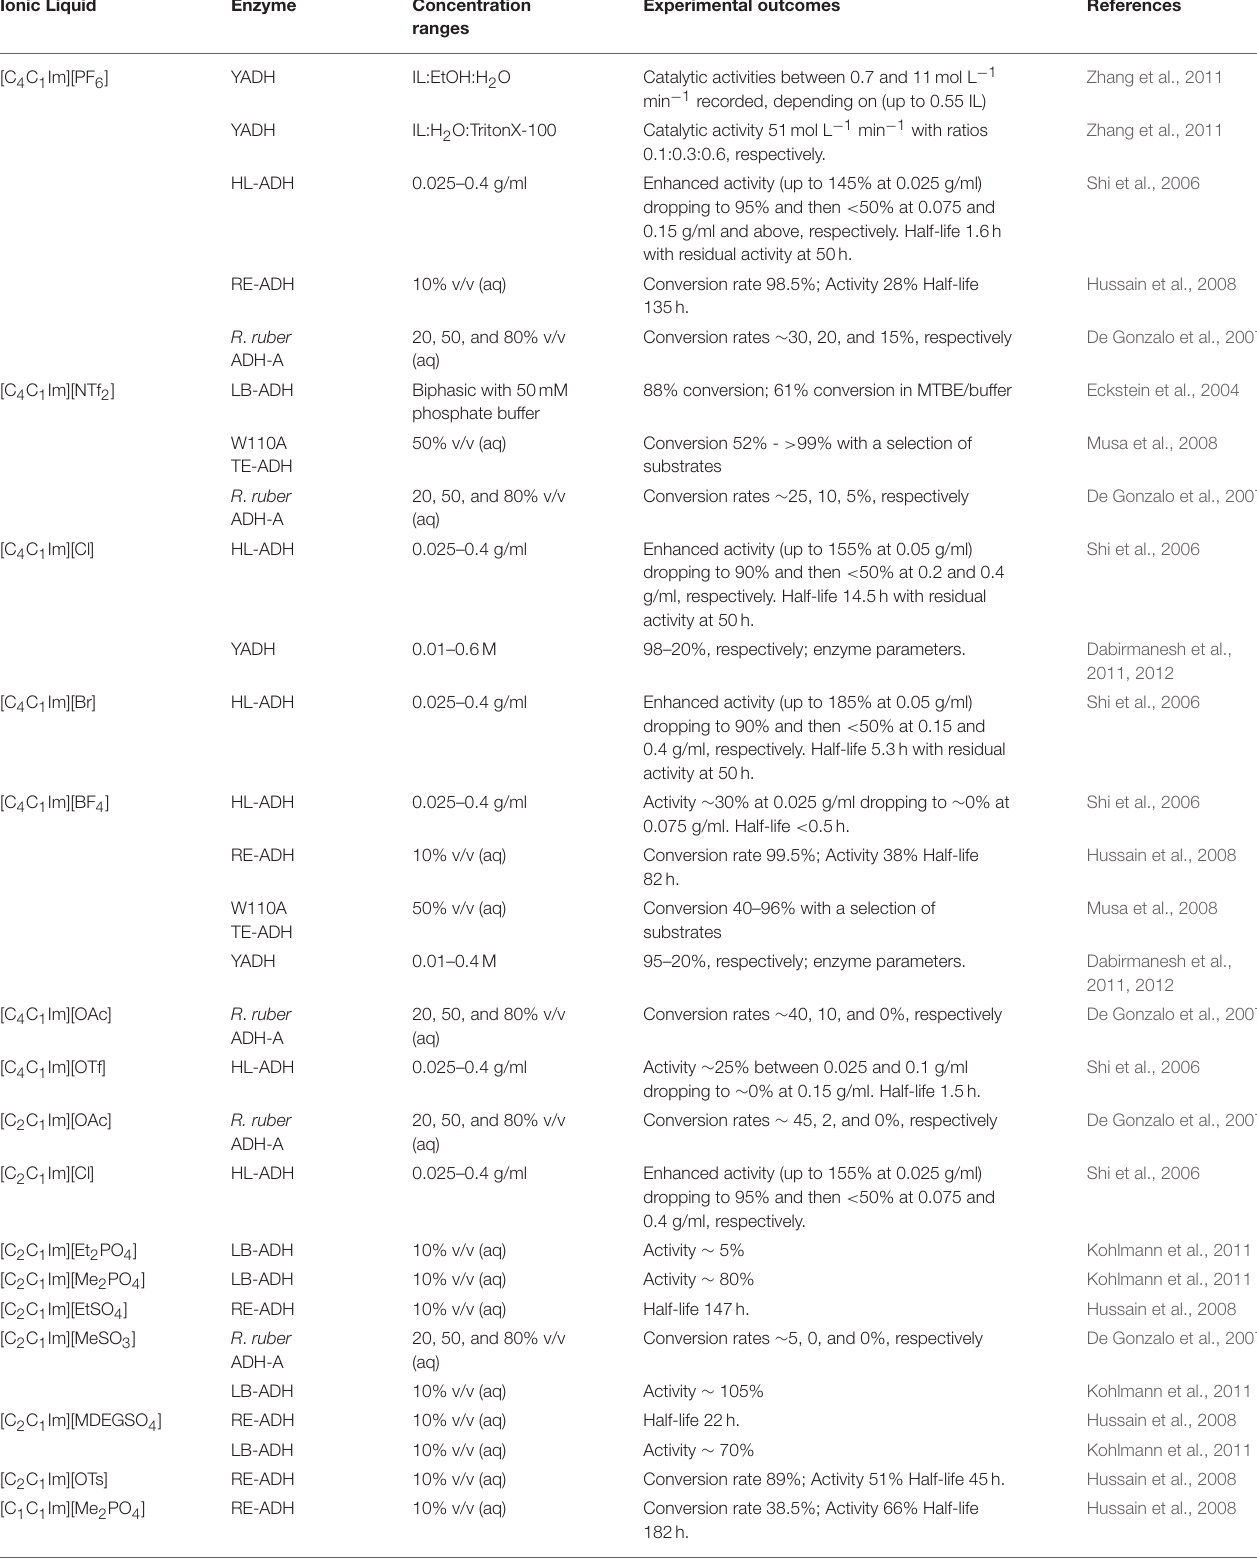
TABLE 5 | Summary of ADH reactions in selected ionic liquids. Ionic